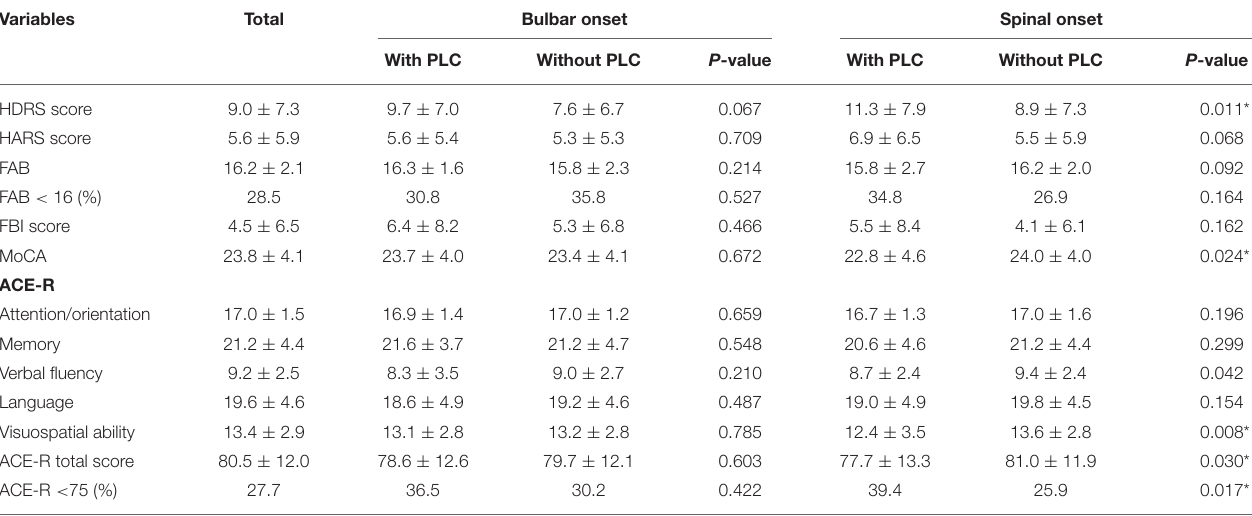
TABLE 2 | Mood and cognitive function of ALS patients with and without PLC. Variables